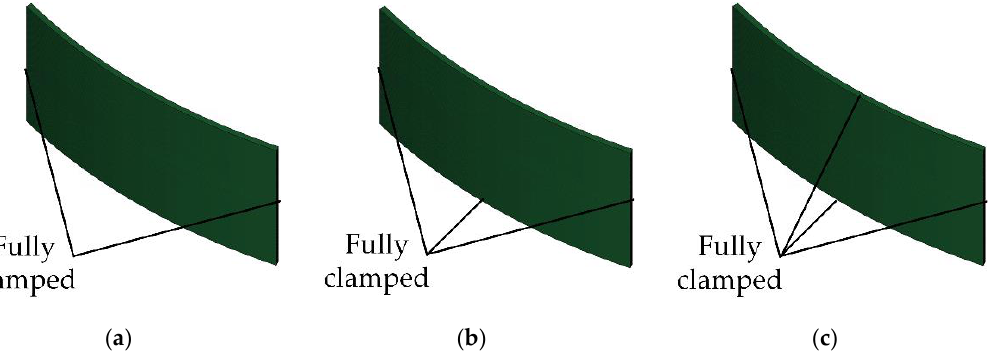
Figure 30. Different boundary conditions. ( a ) Two sides fixed; ( b ) Three sides fixed; ( c ) Four sides fixed.